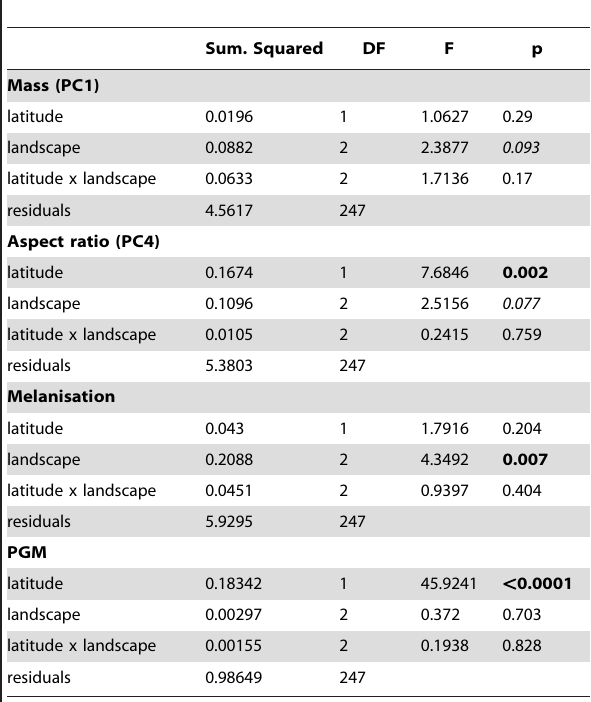
Table 2. Signatures of selection in morphology and